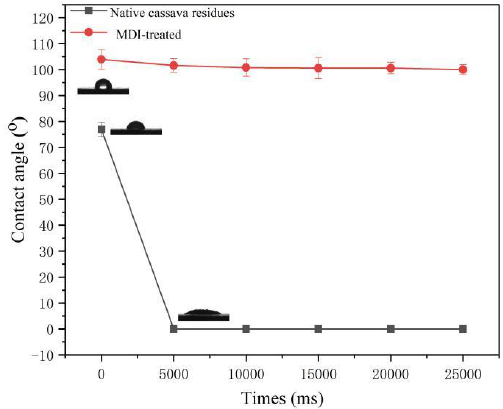
Figure 3. Variation in contact angle with time.